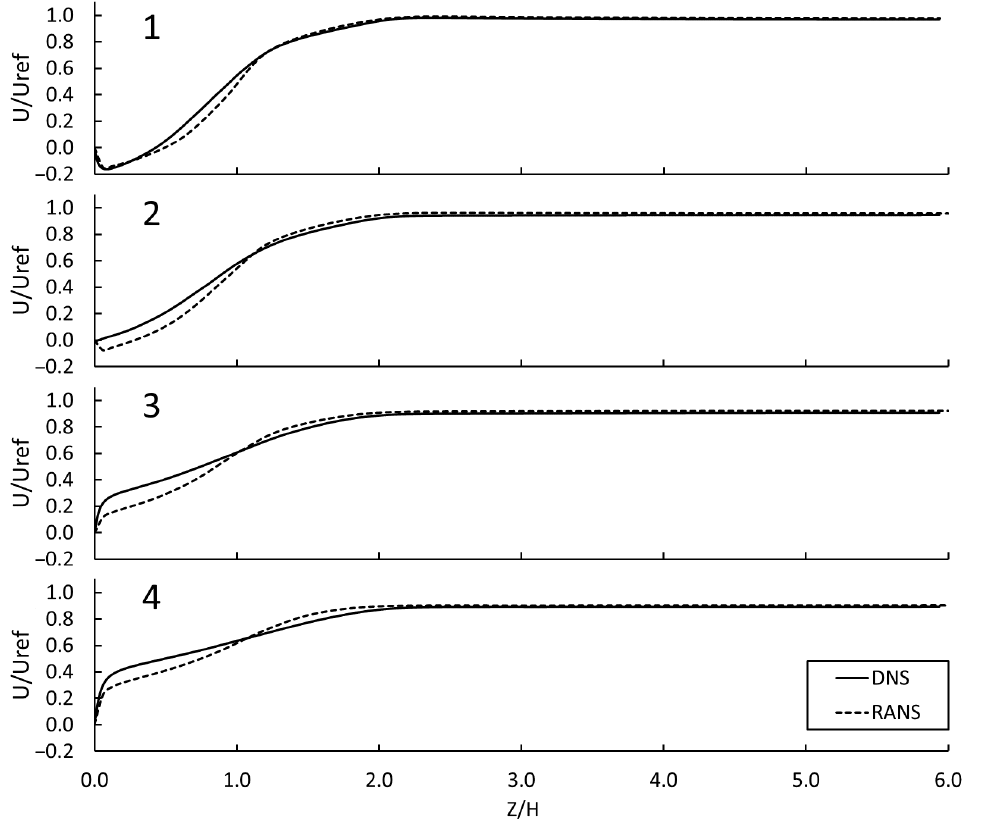
Figure 12. Vertical distributions of axial velocity for the k - ω SST model in comparison with DNS data by Le and Moin [38] at several positions downstream of the step normalized by step height H. (1): X/H = 4, (2): X/H = 6, (3): X/H = 10, (4): X/H =